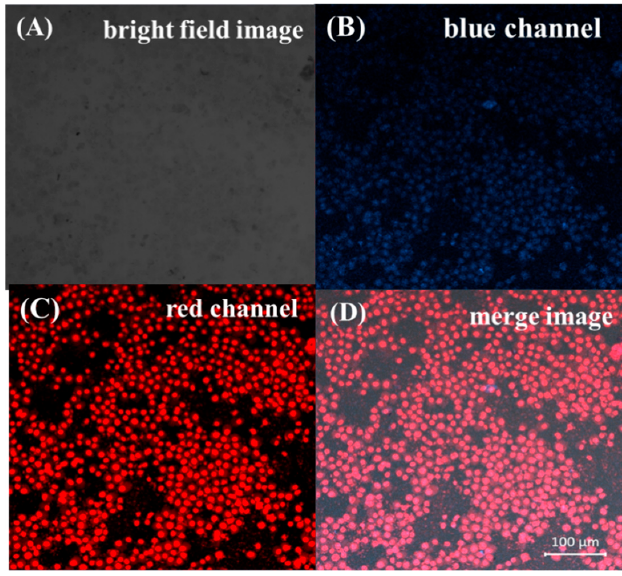
Figure 7. Confocal laser scanning microscopy images of the HEK293T cells incubated with the Cu NCs and then stained with EB. ( A ) Bright field images; ( B ) images of cells labeled Cu NCs at 380-nm excitation; ( C ) images of EB-labeled cells at 583-nm excitation; ( D ) overlap of the above three images.